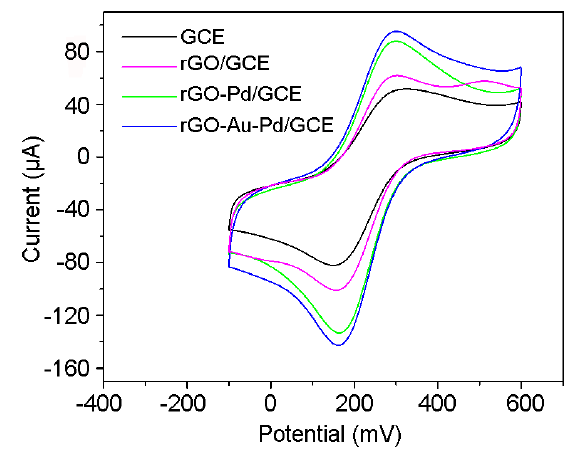
Figure 2. Measurement of the microscopic electroactive areas of GCE, rGO / GCE, rGO-Pd / GCE, and rGO-Au-Pd / GCE. Cyclic voltammograms generated by the indicated electrodes recorded in 10 mM K 3 [Fe(CN) 6 ] at a scan rate of 50 mV / s.